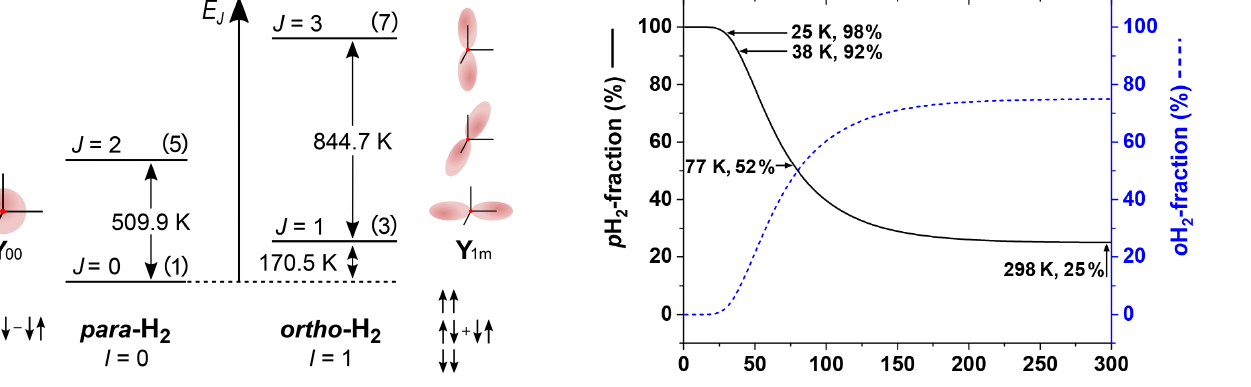
Figure 1. The rotational energy level diagram for isolated H 2 . The angular distribution of the two lowest rotational states ( Y 00 cor- responds to J = 0, and Y 1 + 1 , Y 1 − 1 and Y 10 correspond to J = 1) and spin states of orthohydrogen and parahydrogen are indi- cated. The numbers in parentheses are the degeneracies of the state 2 J + 1. The energy of rotation spin states in units of K is equal to E J = J ( J + 1) θ R with θ R = 87 . 6K (Atkins and De Paula, 2006). The distance between two adjacent energy levels is E J + 1 − E J = 2( J + 1) θ R . The figure was inspired by an illustration of I. F. Sil- vera (1980).